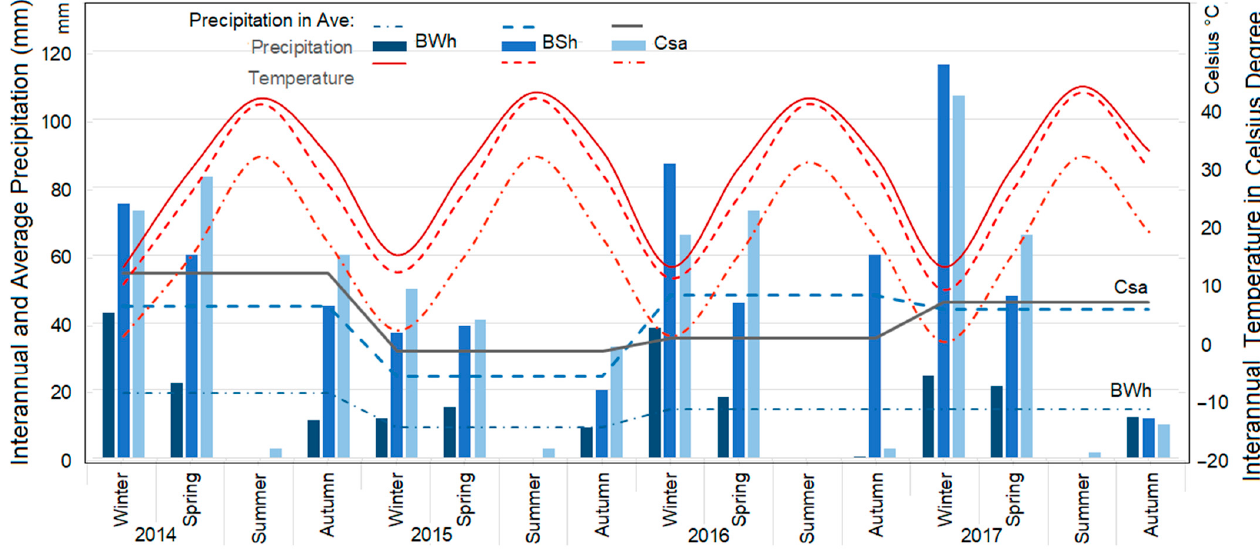
Figure 4. Interannual average temperatures (reddish trend lines) and monthly precipitation (bluish bar chart) of three climate zones (BWh, BSh, and Csa). Axis on the left side represents precipitation value (in mm) and axis on the right side represents temperature (in Celsius).